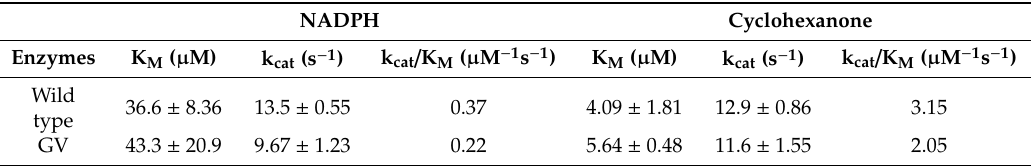
* The steady-state kinetics of CHMO reacting with various concentrations of cyclohexanone (0.002–0.1 mM) and NADPH (0.005–0.2 mM) were performed at pH 7.7 and 25 ◦ C. The second substrate NADPH or